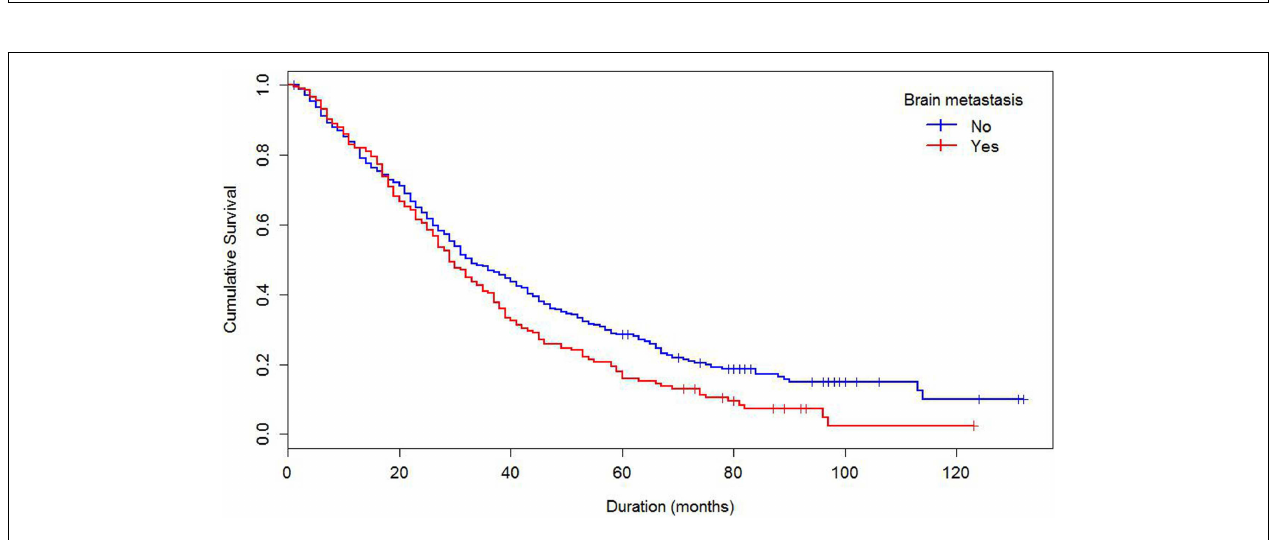
FIGURE 1 | Kaplan–Meier’s curve of survival by visceral metastasis status .